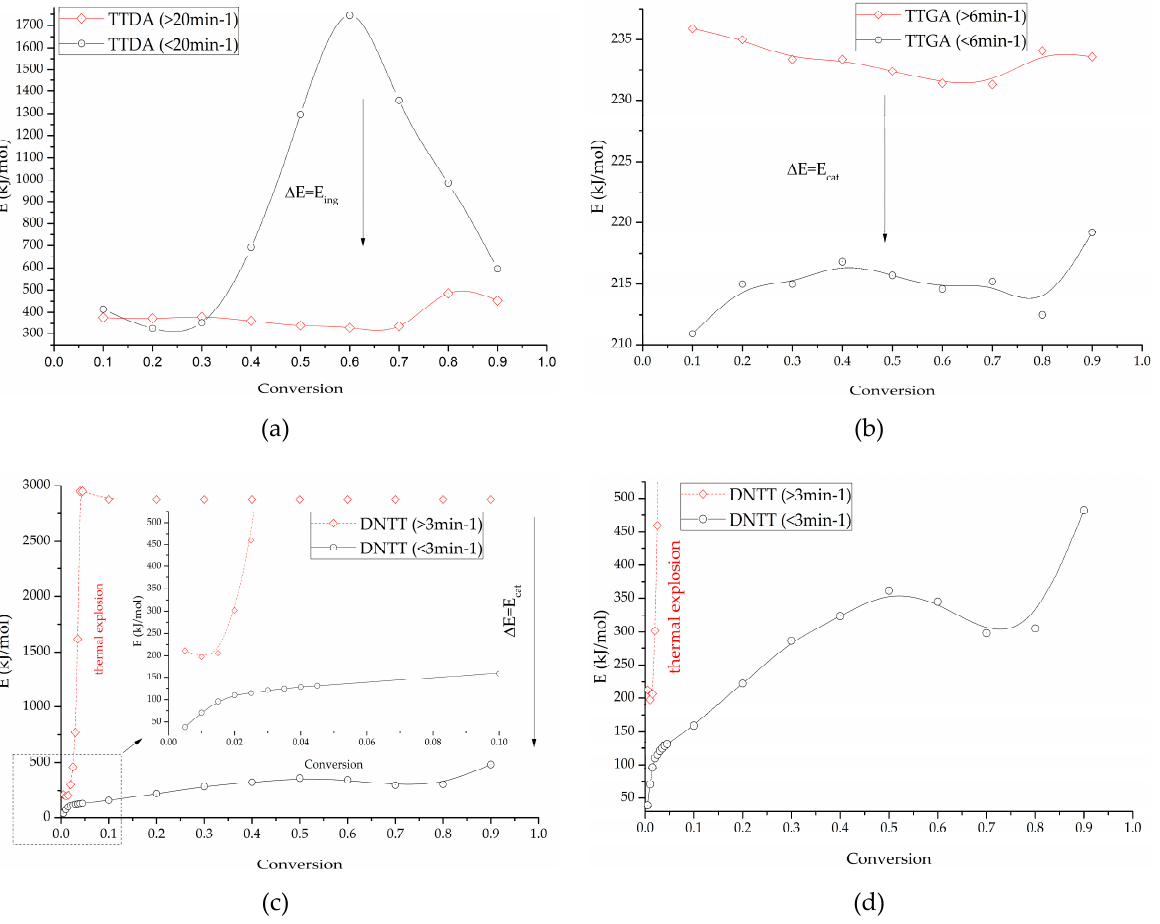
Figure 14. Changes in the induction energy of intensive decomposition processes depending on the catalytic contribution (taking into account gas-phase decomposition and in the absence of gas-phase decomposition) for: TTDA ( a ); TTGA ( b ) and DNTT ( c , d ).